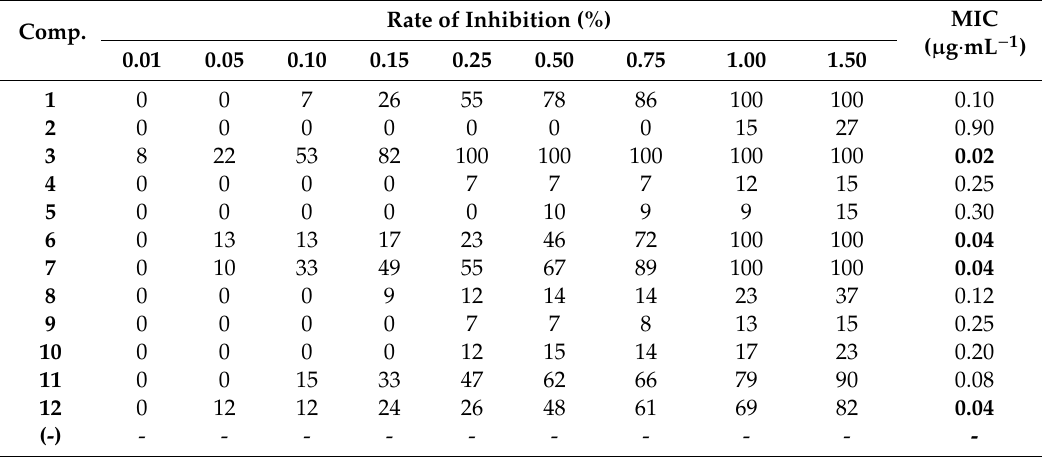
Table 1. Rate of inhibition of the growth of F.o.a according to the concentration of the tested compounds (0.01–1.50 µ g · mL − 1 ) and the MIC values.